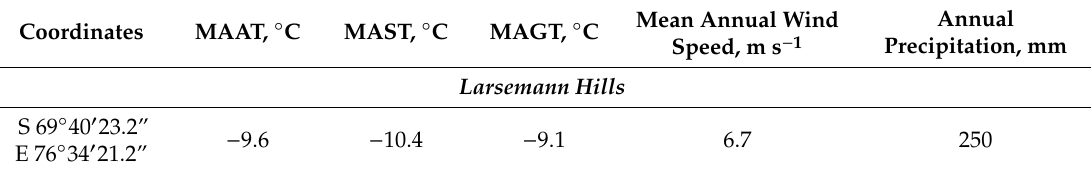
Table 1. Climatic characteristics of Larsemann Hills, Eastern Antarctica [27].